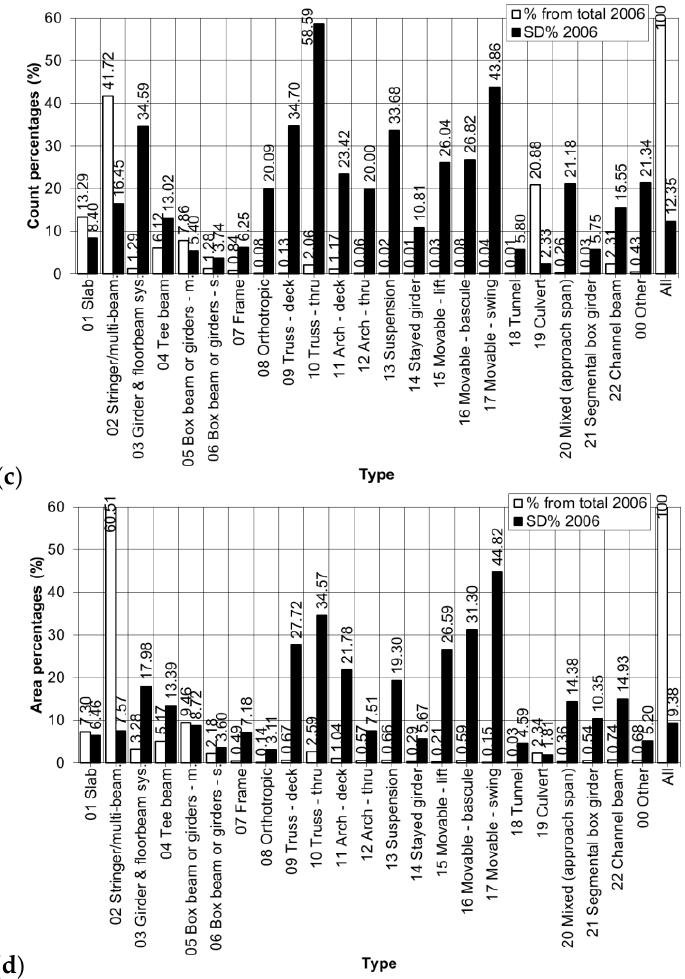
Figure 1. Comparison of percentages of bridge types from the total and SD percentages. (a) Counts 2013; (b) Areas 2013; (c) Counts 2006; (d) Areas 2006.